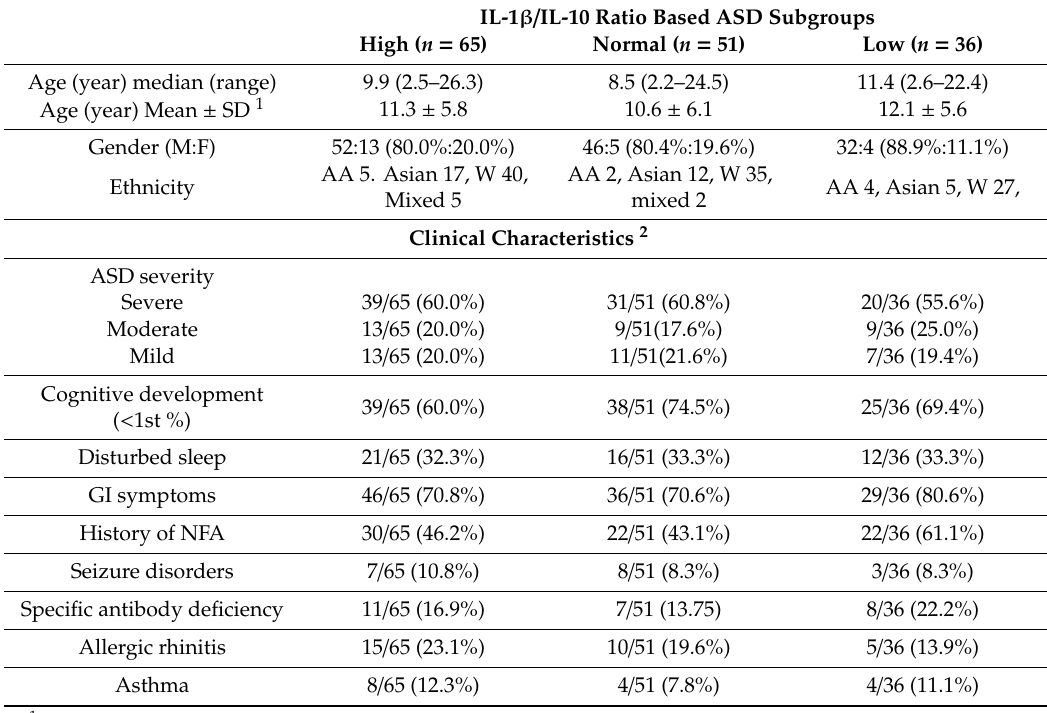
Table 1. Demographics and clinical features in the IL-1 β / IL-10 based autism spectrum disorder (ASD)